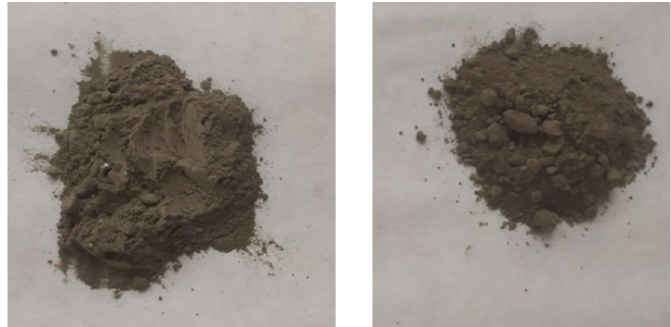
Figure 1. Fly ash ( right ) and titanium dioxide waste ( left ).